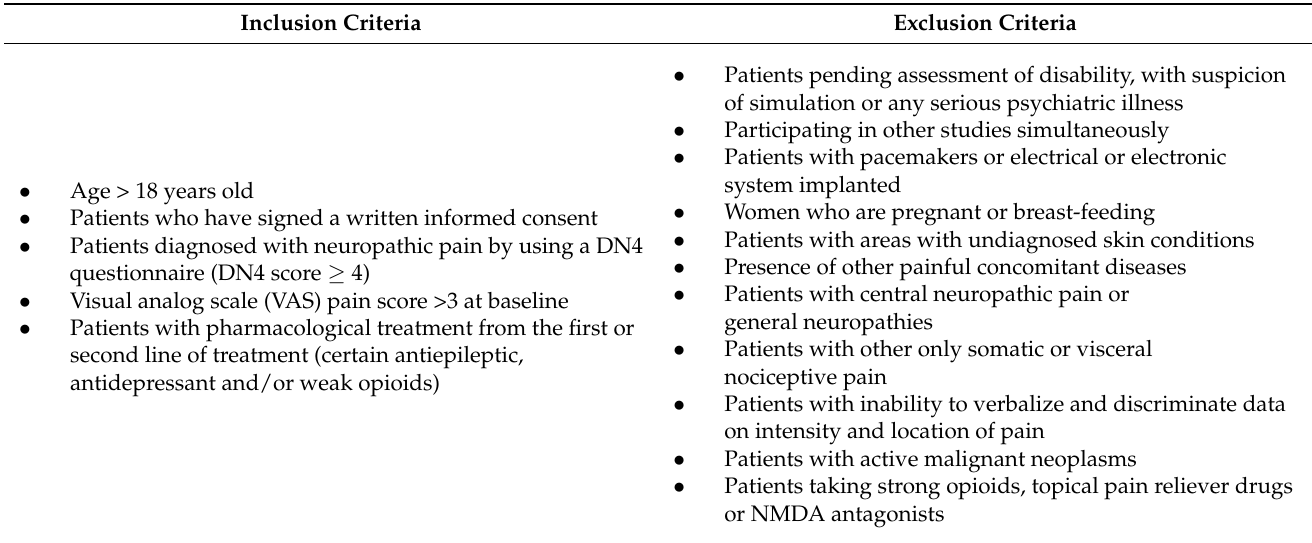
Table 1. Inclusion and exclusion